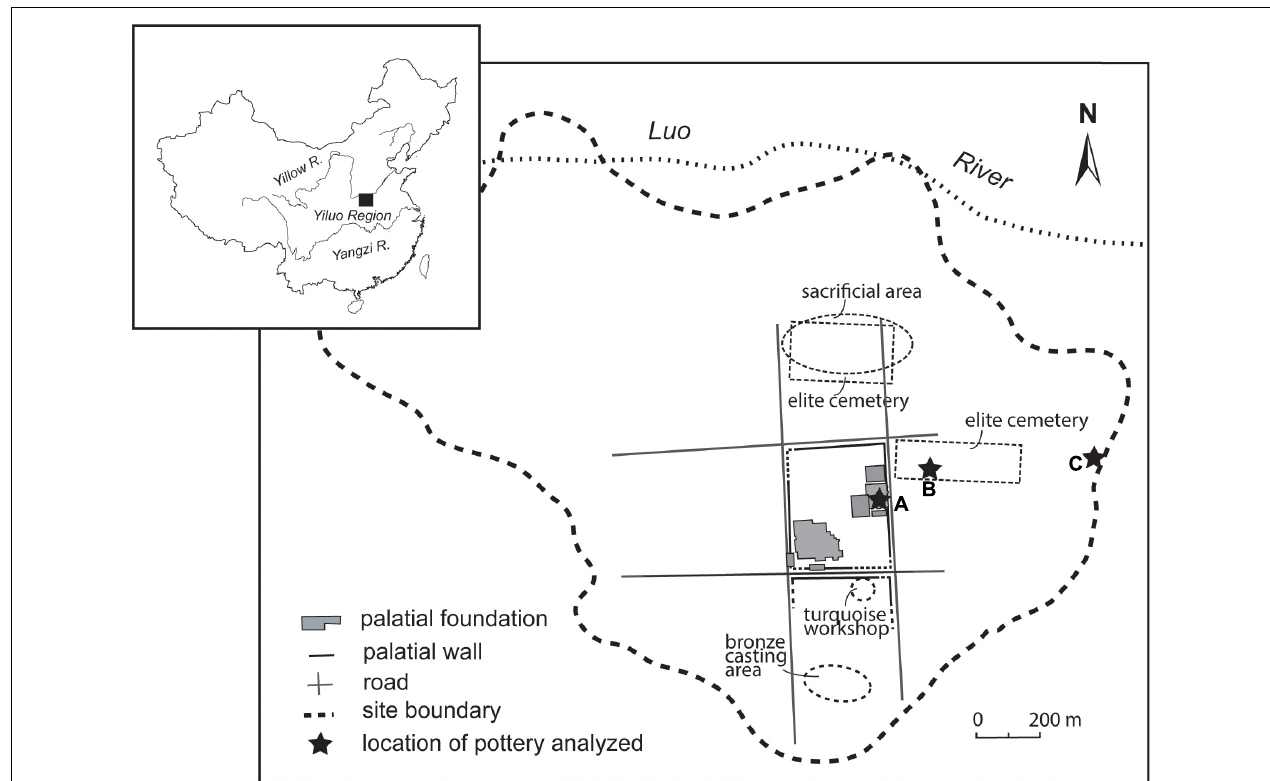
FIGURE 1 | Locations of pottery samples excavated from the Erlitou site in the Yiluo region. (A) General area where pottery sherds were unearthed from the eastern part of the palatial zone; (B) location of the elite tomb 2015YLVM7; (C) location of